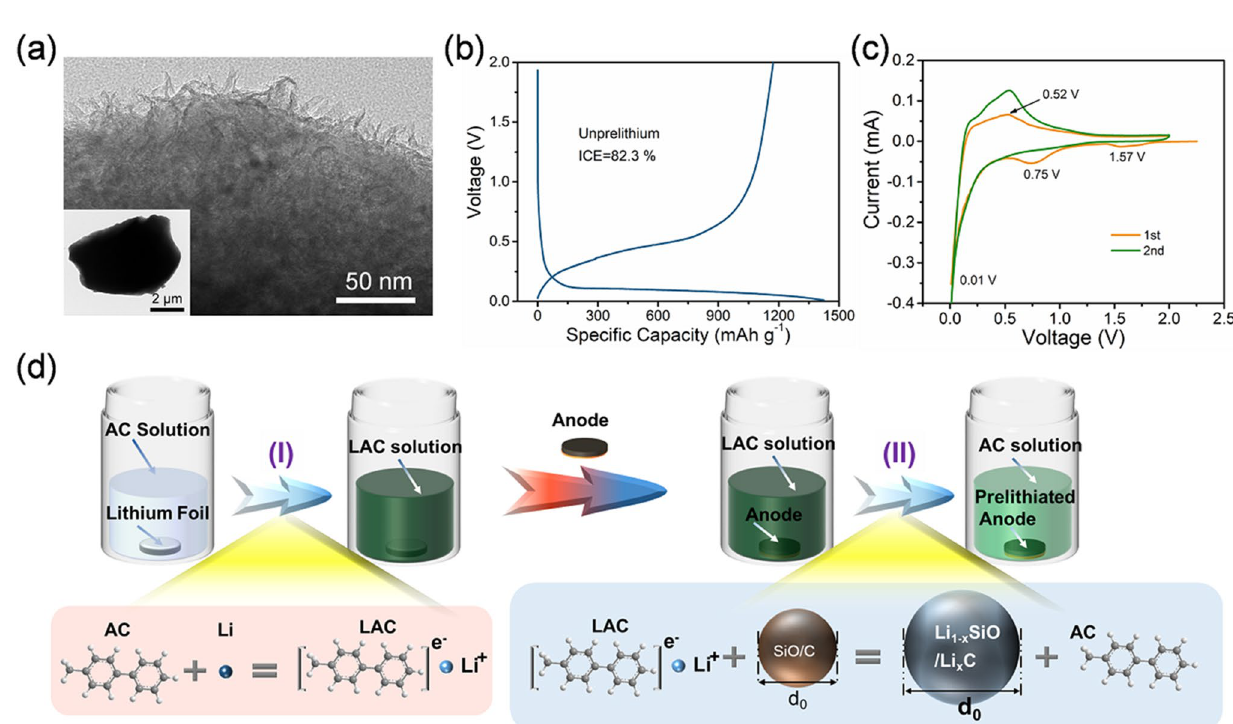
Fig. 1 a TEM images of SiO/C particle. b Initial discharge–charge profile and c CV curve of SiO/C anodes. d Schematic illustration of the prelithiation process of SiO@C